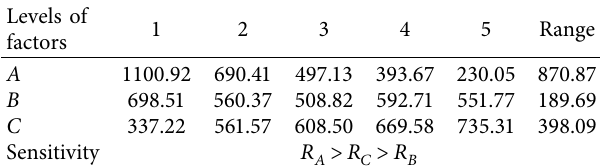
Table 12: Sensitivity analysis of elastic modulus to three factors. Levels of